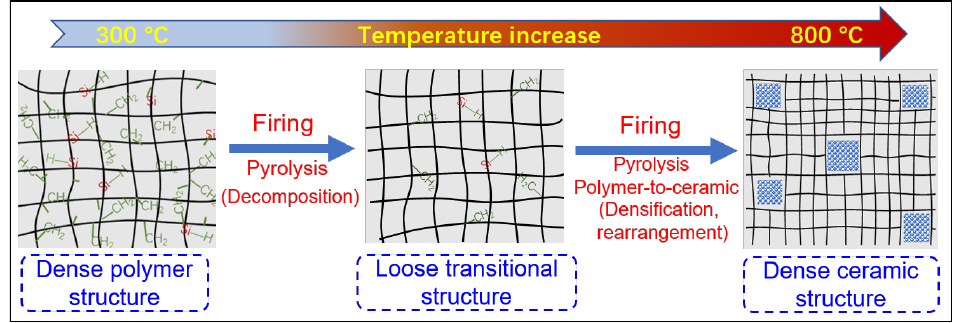
Figure 15. Schematic of the evolution of the network structure for polymeric precursors (e.g., AHPCS) pyrolyzed at different temperatures. Reprinted from [73] with permission from Elsevier.